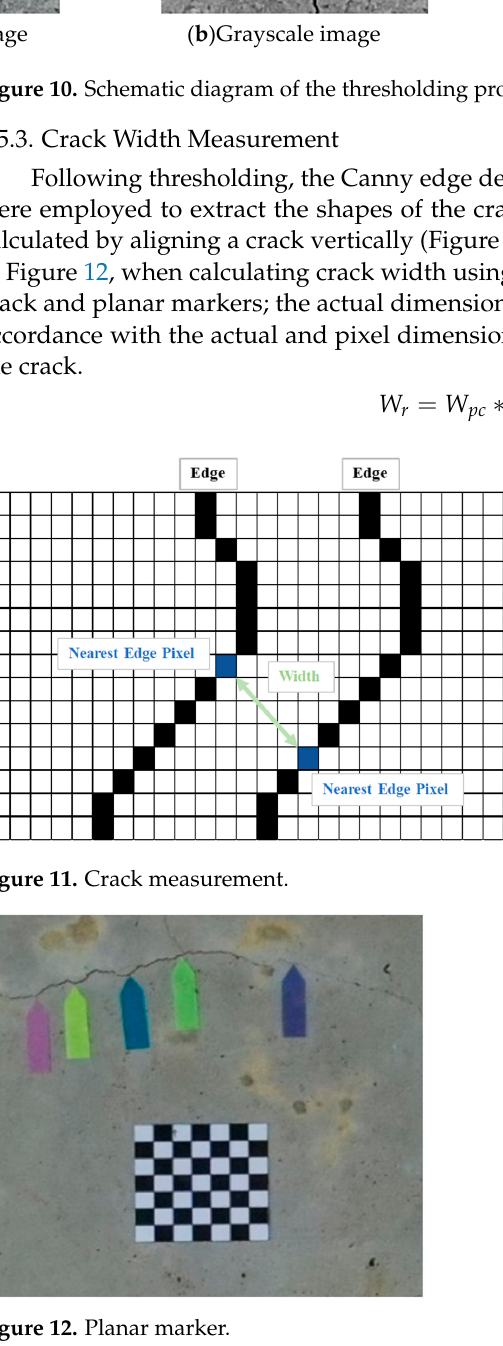
Figure 12. Planar marker. 3. Experiment Analysis 3.1. Outdoor Bridge Inspection Tests The training process was implemented on a server with a high-performance GPU (NVIDIA GeForce GTX 1060), 64 GB DDR4 memory, and an Intel(R) Core™ i7-8700K CPU.